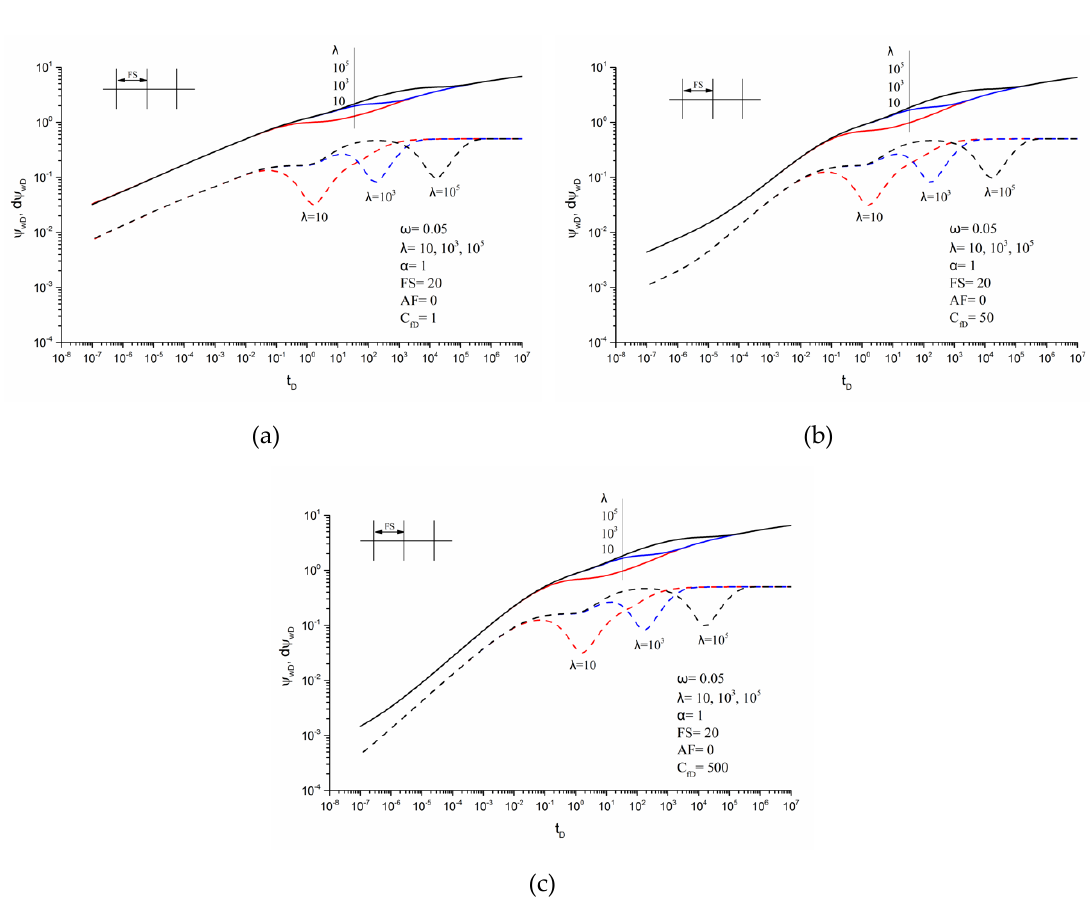
Figure 8. The typical pseudo-pressure curves of a multi-fractured horizontal well with different inter-porosity flow coefficient. (a) Low conductivity; (b) intermediate conductivity; (c) high conductivity.